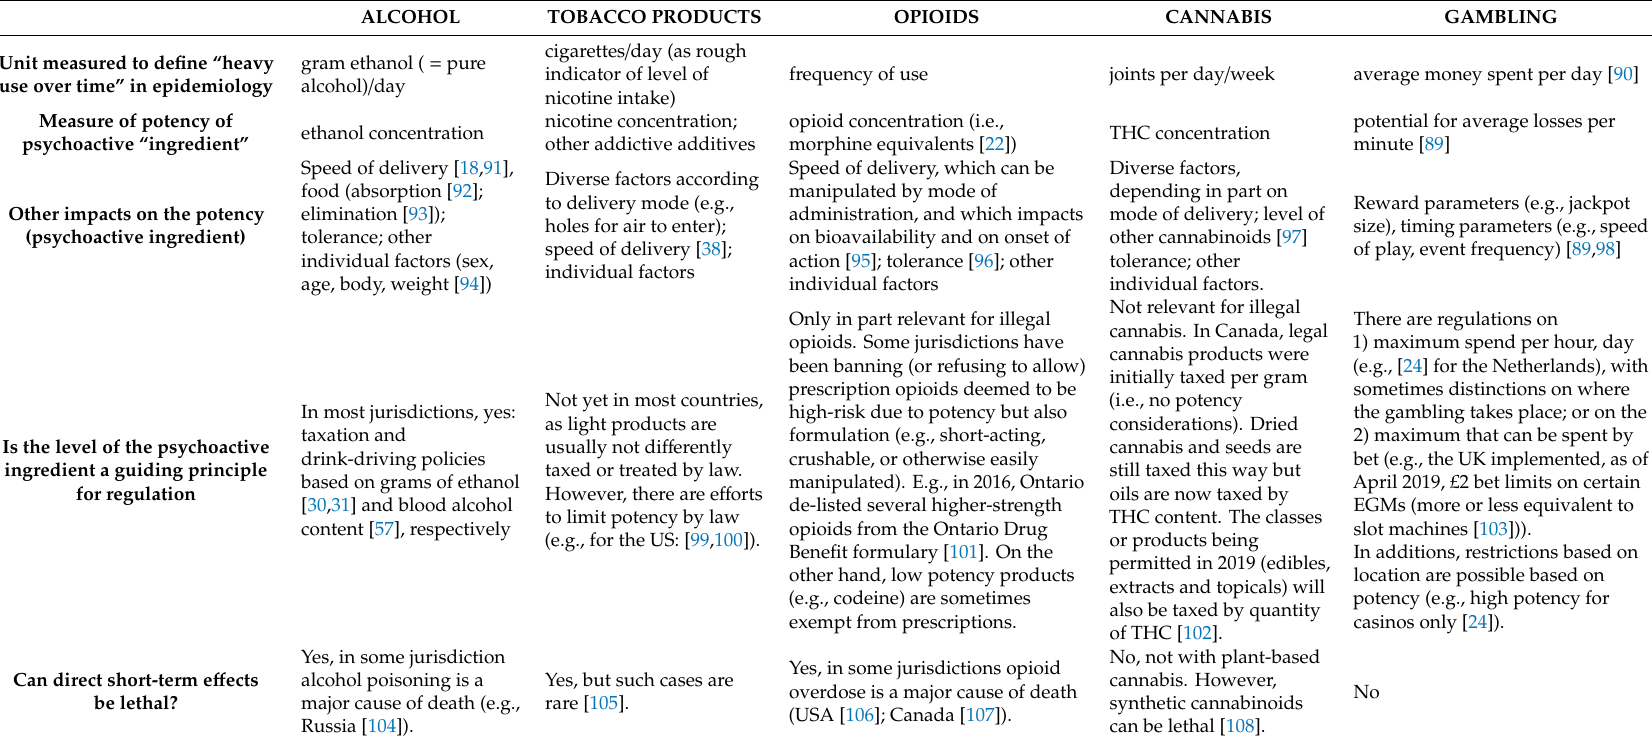
Table 1. Level of use and potency in the regulation of psychoactive substances and addictive